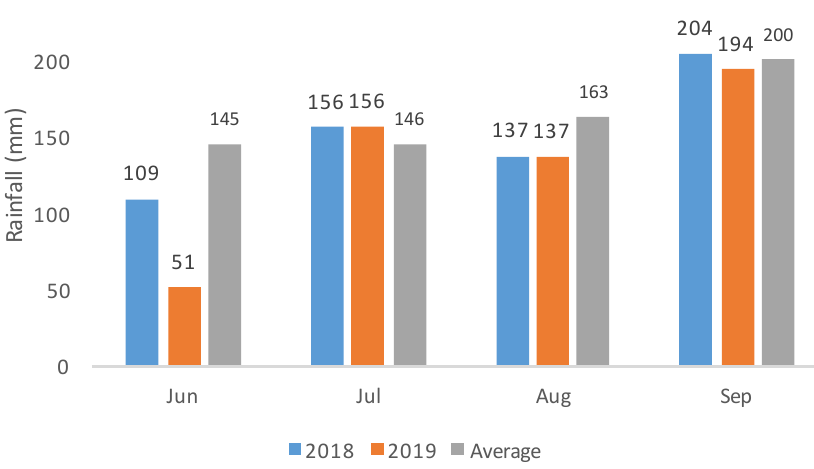
Figure 4. Rainfall during the crop growth period.